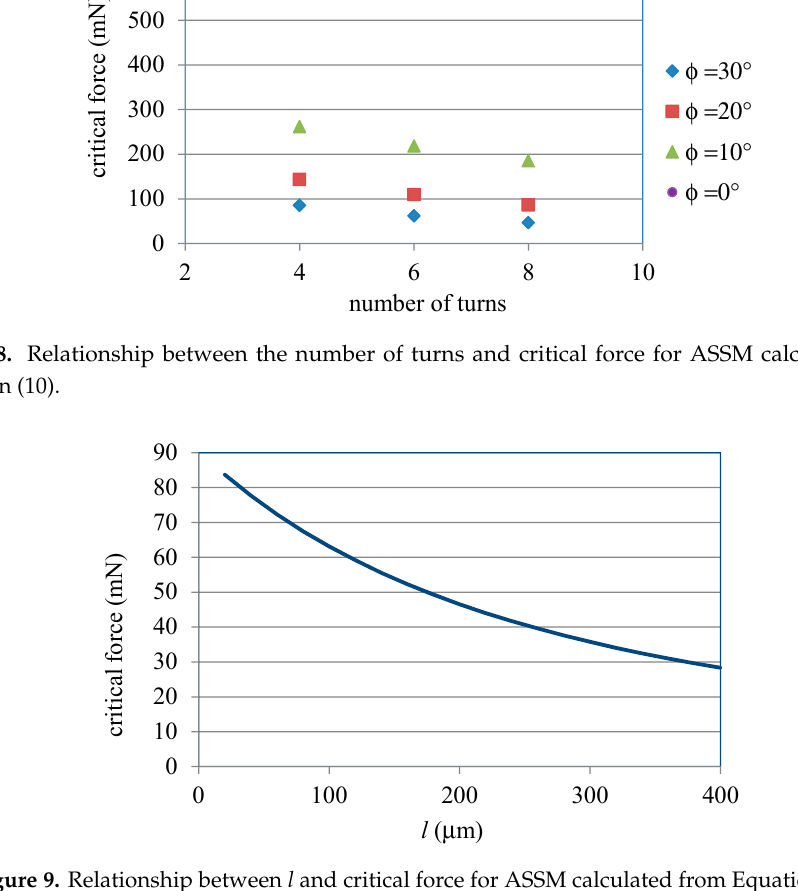
Figure 9. Relationship between l and critical force for ASSM calculated from Equation (10).